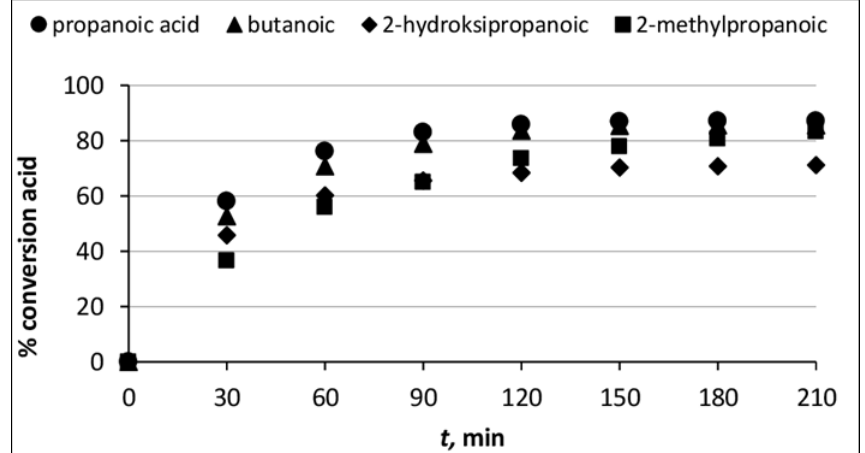
Figure 2. Influence of the length of the alkyl line and substituent in acid side chain on the rate and yield of esterification reaction with 1-propanol. Conditions: molar ratios: acid/alcohol/catalyst (H